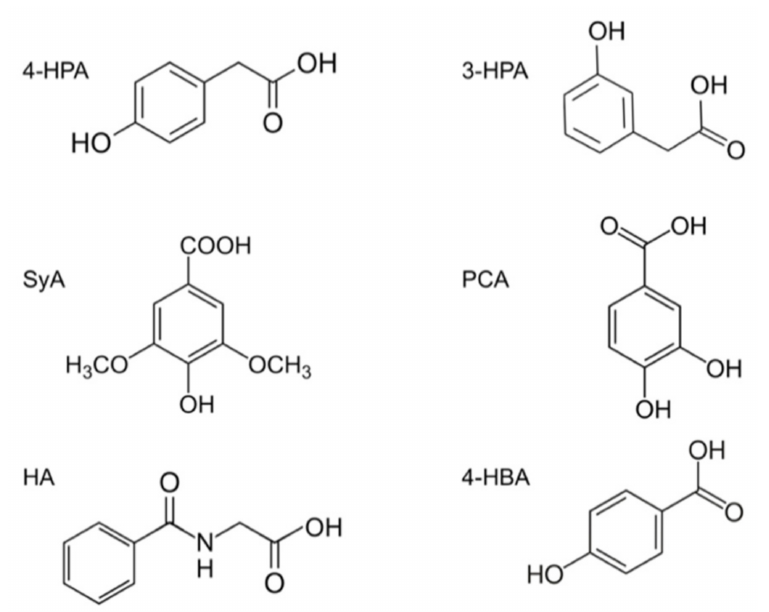
Figure 1. Chemical structures of the template (4-HPA) and its analytes analogues (3-HPA, PCA, 4-HBA, SyA, and HA).